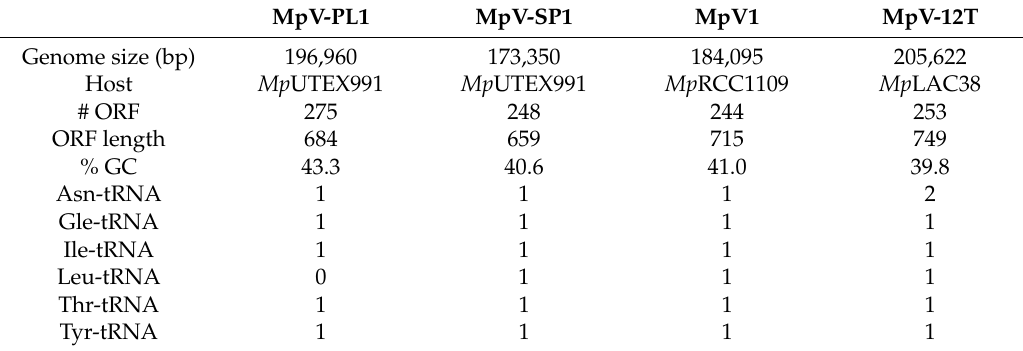
Table 1. General genome characteristics of Micromonas pusilla (MpV)-PL1 and MpV-SP1 compared to MpV1 and